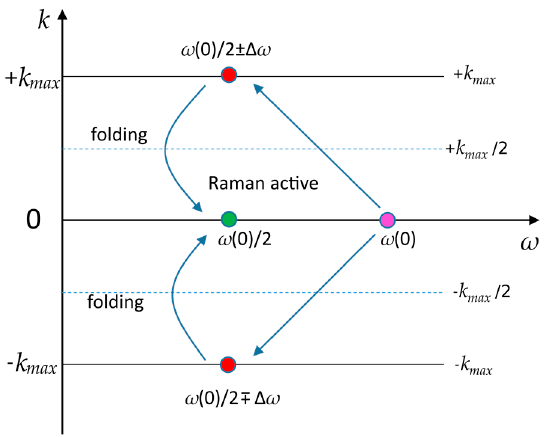
Figure 5. Illustration of zone folding induced by a pair of phonons on the opposite MBZ edges forming phonon grating. A pair of phonons is excited by the subharmonic decay of mode ω (0). In the DBR, at the MBZ edge wavevector is expressed as k = k max = π / d DBR . The mirror symmetry operation with respect to ± k max /2 boundaries enables the MBZ-edge modes ( ω (0)/2 + ∆ ω , + k max ) and ( ω (0)/2 − ∆ ω , − k max ) to be folded into the MBZ-center k ≅ 0. In our situation, due to ∆ ω ≪ ω (0)/2, the difference between ω (0)/2 + ∆ ω , ω (0)/2 and ω (0)/2 + ∆ ω are not given in the plot. We assume that all those modes are ≅ ω (0)/2.